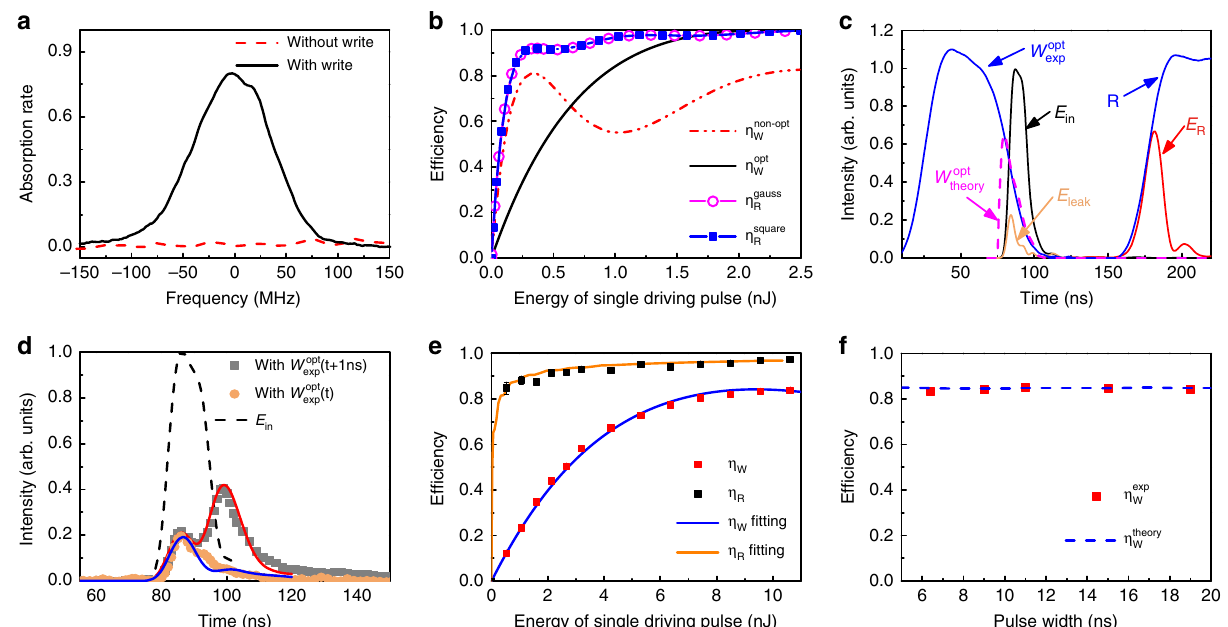
Fig. 2 Ef fi cient Raman memory. a Absorption rate of the weak input-signal pulse as a function of the Raman detuning frequency. Δ W is fi xed at 3.0 GHz. The input signal pulse is 10 ns long. b Theoretical ef fi ciency as a function of the energy of the strong control pulse. The input optical pulse is a 10 ns near- square pulse. All optical fi elds detune 3.0 GHz from atomic transition and the optical depth d = 1100 (see Methods section for details). In the write process, the ef fi ciency is always much smaller than 1.0 when using a non-optimal write pulse (10 ns Gaussian shape), but it can approach 1.0 with the optimal write pulse when the write pulse is larger than 1.5 nJ. In the read process, the curves with Gaussian and square read pulses coincide with each other. The retrieval ef fi ciency is waveform-independent and increases with the energy of the read pulse until approaching 1.0. c Temporal modes of the strong driving (blue, experimental shape of write pulse W opt , read pulse R ; dashed purple, theoretical shape of optimal write pulse W opt ), input signal (black, E in ), leaked signal exp theory ð t Þ (orange circle) and W opt ð t þ 1 ns Þ (gray square) write (orange, E leak ), and output signal (red, E R ) pulses. d Waveform of the leaked signal with the W opt exp exp pulse. The lines are the corresponding theoretical fi ts. e Storage ef fi ciency ( η W ) and retrieval ef fi ciency ( η R ) as function of the energy of the driving pulse (W and R) with the shape of W opt and R as shown in ( c ). Square represents experimental data and solid line is theoretical fi tting. The error bars correspond exp to one standard deviation caused by the statistical uncertainty of measurement. f The write-in ef fi ciency as a function of the width of the E in